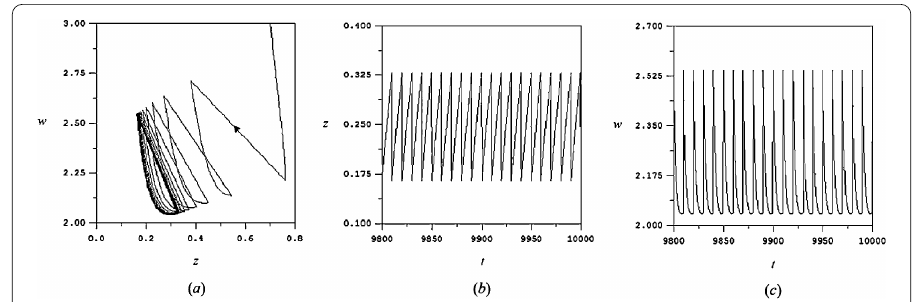
Figure 2 Numerical simulation of equations (4a)-(4d). The solution trajectory is bounded within a positive range as time passes. Here, all parameters are chosen to satisfy the conditions in Theorem 2, a 1 = 0.2, a 2 = 0.3, a 3 = 0.21, a 4 = 0.9, a 5 = 0.4, b 1 = 0.7, b 2 = 0.5, b 3 = 0.1, b 4 = 0.3, k 1 = 0.5, k 2 = 1.9, k 3 = 0.9, k 4 = 0.9, k 5 = 0.01, k 6 = 0.75, μ = 0.5, ρ = 0.5, T = 10, z (0) = 0.7, and w (0) = 3. (a) The solution trajectory projected on ( z , w )-plane. (b) The corresponding time course of the number of active osteoclasts ( z ) and (c) The corresponding time course of the number of active osteoblasts ( w ).